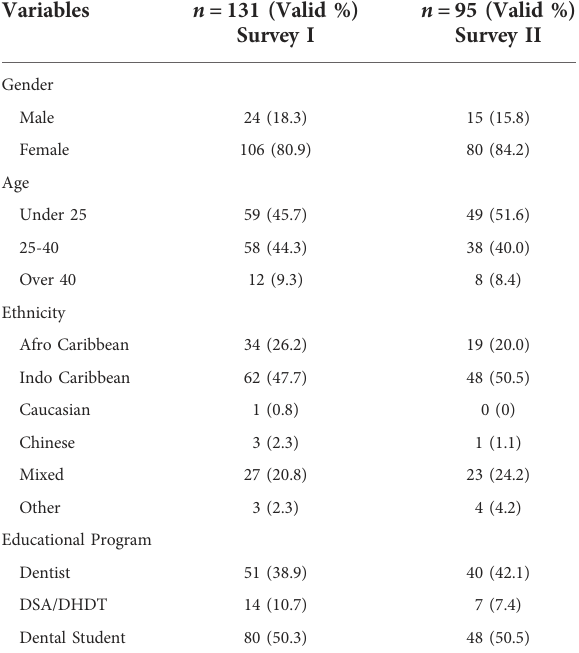
TABLE 2 Participants ’ reasons for attendance at the workshop - generated themes.